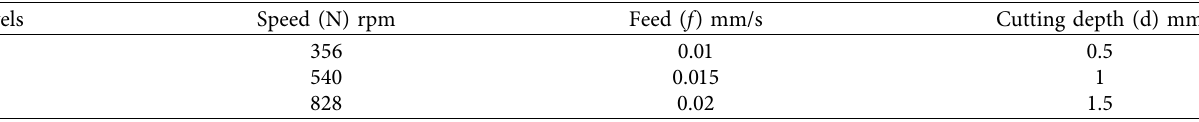
Figure 5: Conventional lathe with the proposed compliant damper and data acquisition systems. Table 1: Various parameters and